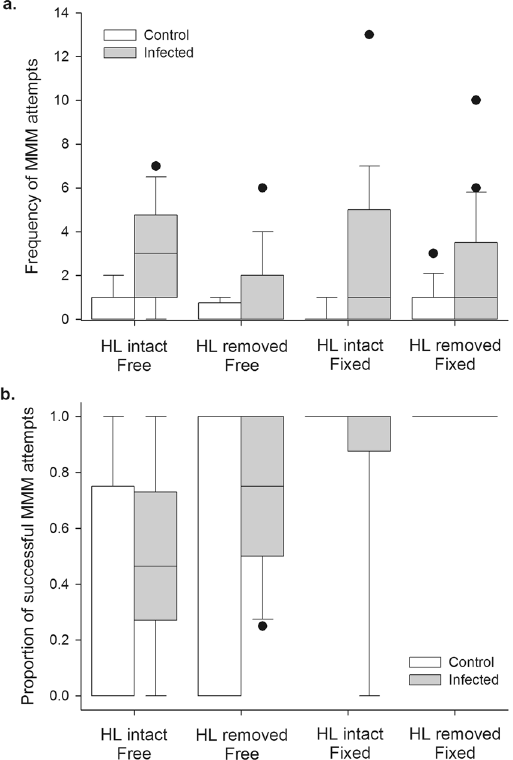
Figure 2. The effect of fungal infection on MMM attempts, and the effect of reduced escape capability on the success of MMM attempts. ( a ) Frequency of MMM attempts by control and fungus-infected focal locusts exposed to otherwise healthy males with hind legs removed, and/or fixed in position, such that they were less able to avoid or resist MMM attempts. Twenty-one control and 24 fungus-infected locusts were observed in total and exposed to each manipulated male type in random order. Due to locust deaths, data for a particular trial type could be missing for a given locust, and actual sample sizes were: HL intact/free – 19 control, 24 infected; HL removed/free – 20 cont., 21 inf.; HL intact/fixed – 19 cont., 23 inf.; HL removed/fixed – 18 cont., 21 inf. ( b ) Proportion of the MMM attempts in part ( a ) that resulted in the mounting male successfully positioning itself on top of the mounted locust in the manner characteristic of males mounting females. The sample comprised only those locusts that made at least one MMM attempt in part ( a ), and were: HL intact/free – 9 cont., 20 inf.; HL removed/free – 5 cont., 10 inf.; HL intact/fixed – 3 cont., 14 inf.; HL removed/fixed – 5 cont., 13 inf. For control locusts exposed to each type of free-moving manipulated male, the median values are zero; for infected locusts exposed to HL intact/fixed males, the median value is one. In both panels, boxes denote the median, 25 th and 75 th percentile values, whiskers the 5 th and 95 th percentile values, and circles the more extreme